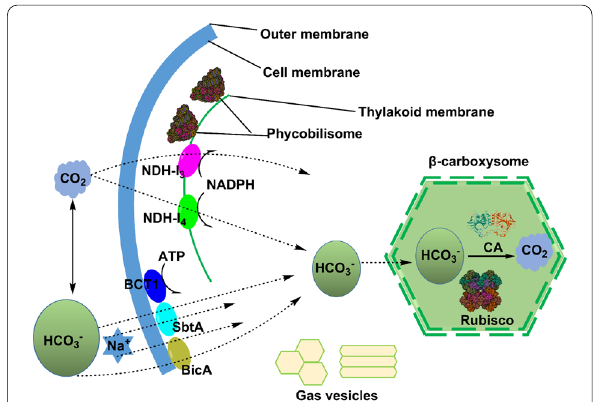
Fig. 2 CO 2 concentration mechanism of a